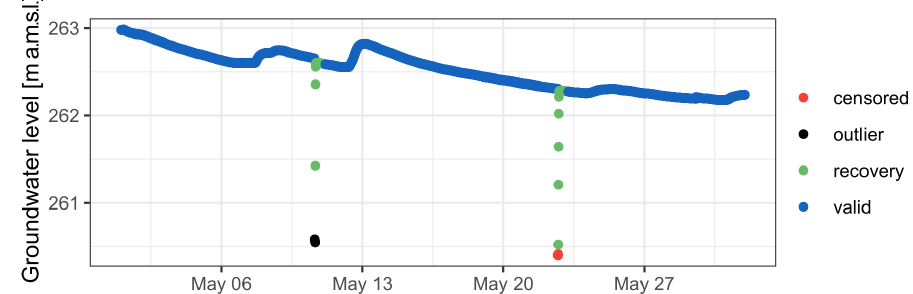
Figure 6. Example of a groundwater time series (well A12; May 2019) affected by two pumping events, with the identification of the outliers (black) during the time that the logger was outside the well (while the pumping took place) and the recovery period (green). Water levels below the threshold of 5cm above the logger end are classified as censored (red).